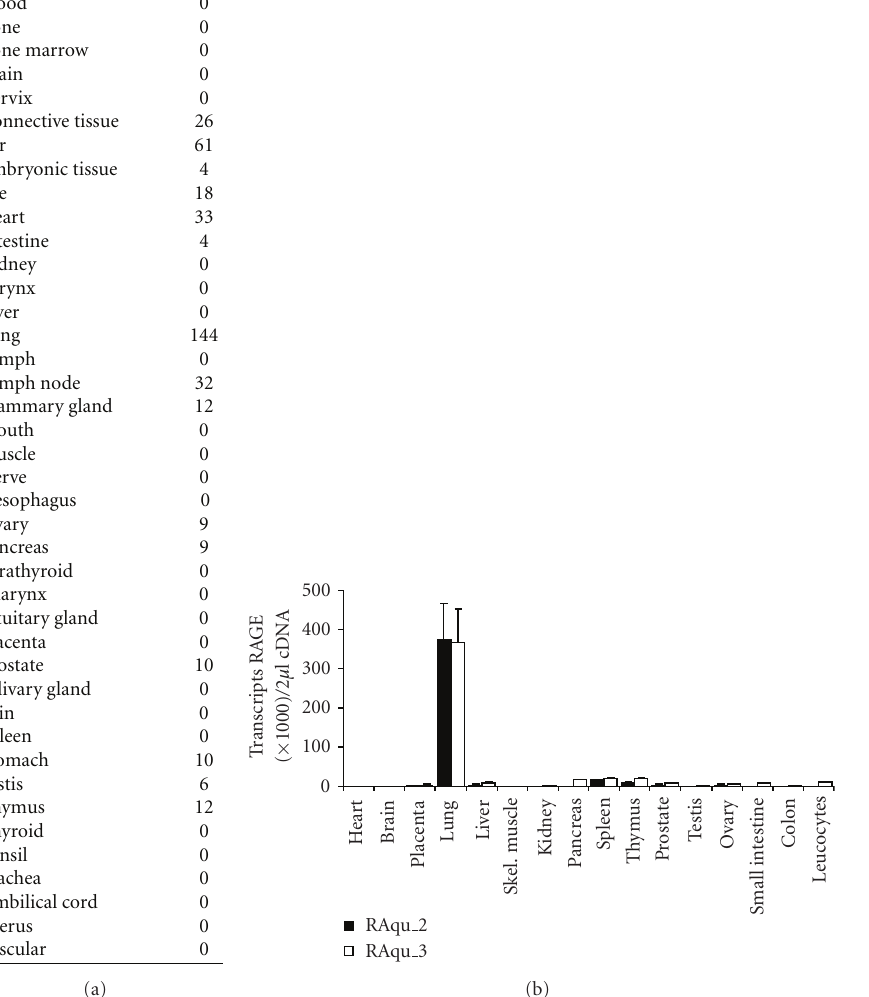
Figure 2: Tissue distribution of RAGE. (a) Relative number of expressed-sequence clones per million identified in tissue and species-specific databases [11]. The table was updated on 07/20/09. (b) Quantitative analysis of RAGE mRNA expression in healthy human tissue. Two sets of RAGE-specific primers, RAqu 2 (black) and RAqu 3 (white), were used to compare RAGE expression in 16 human tissues of healthy donors in quantitative RT-PCR analysis. The transcript numbers of RAGE were compared with the transcript numbers of GAPDH in 2 μ L cDNA. The mean and SEM of two separate light cycler runs are displayed (adapted from